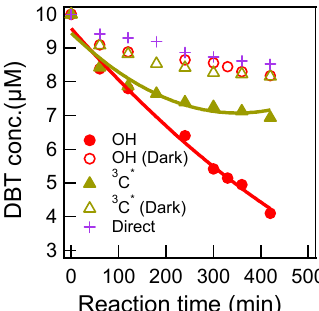
Figure 1. Concentrations of the precursor (dibenzothiophene, DBT) during aqueous oxidation under different conditions. Table 1. Experimental conditions and the decay parameters of DBT.